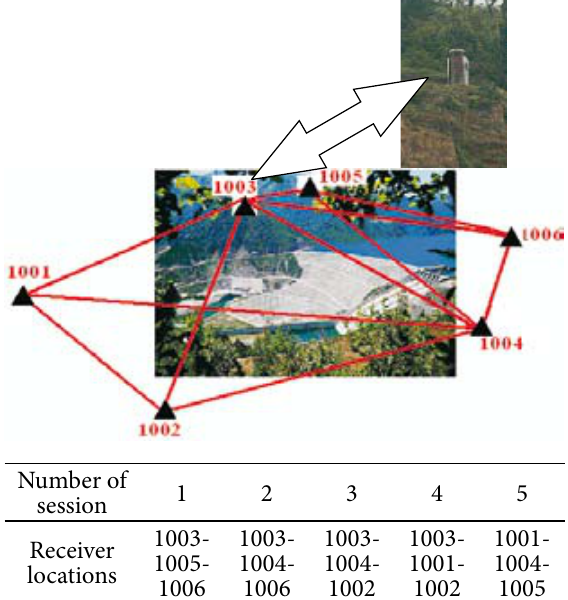
Fig. 2. Reference network of Altýnkaya dam and measurement